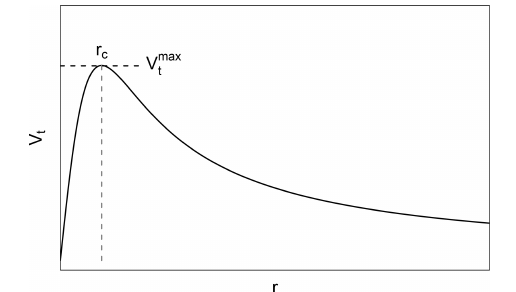
Figure 8. Qualitative plot of the tangential velocity from the vortex core outwards. The tangential velocity increases from zero (left) to a maximum at a distance r c and decreases to zero for large distances (to the right).